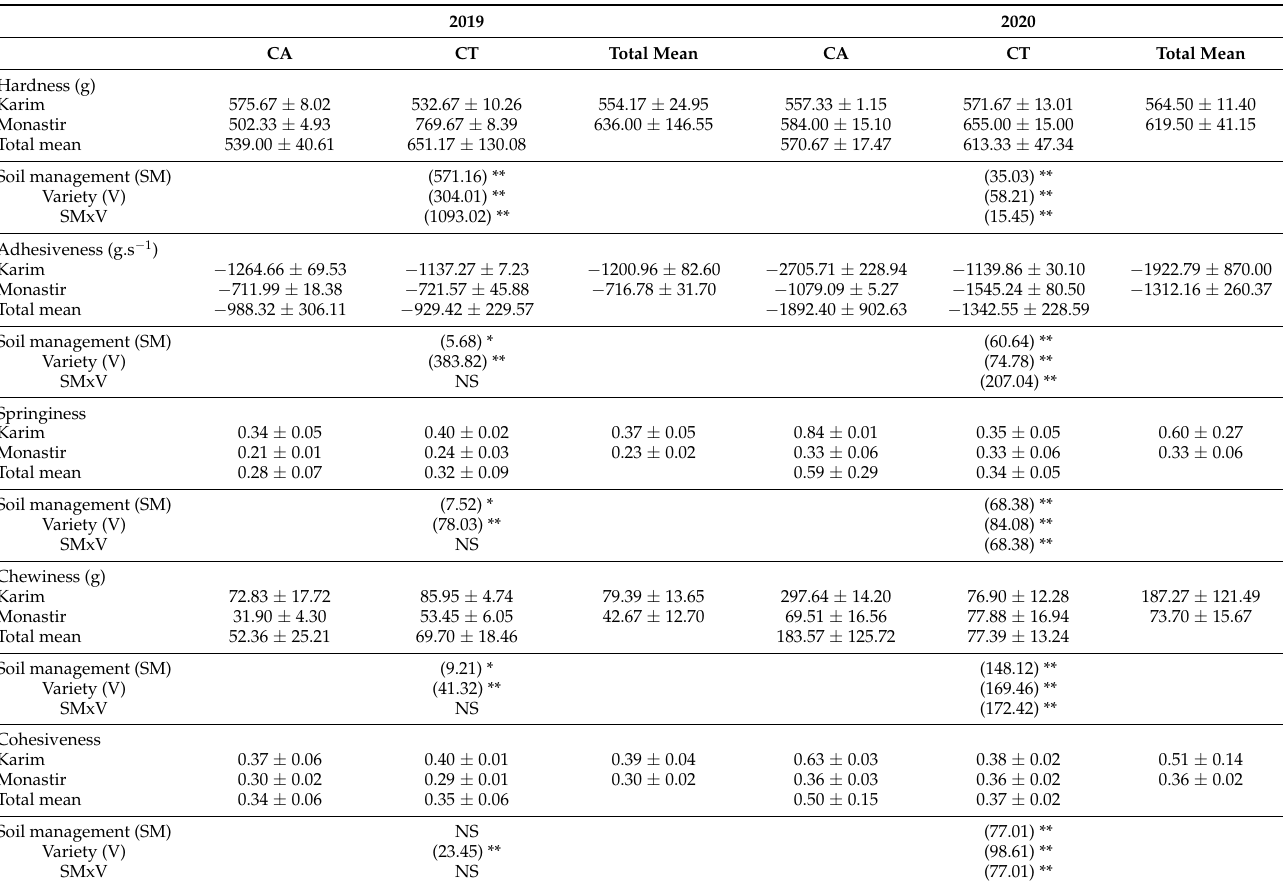
Table 3. Dough texture profile parameters of two durum wheat varieties under two soil management systems grown over two cropping